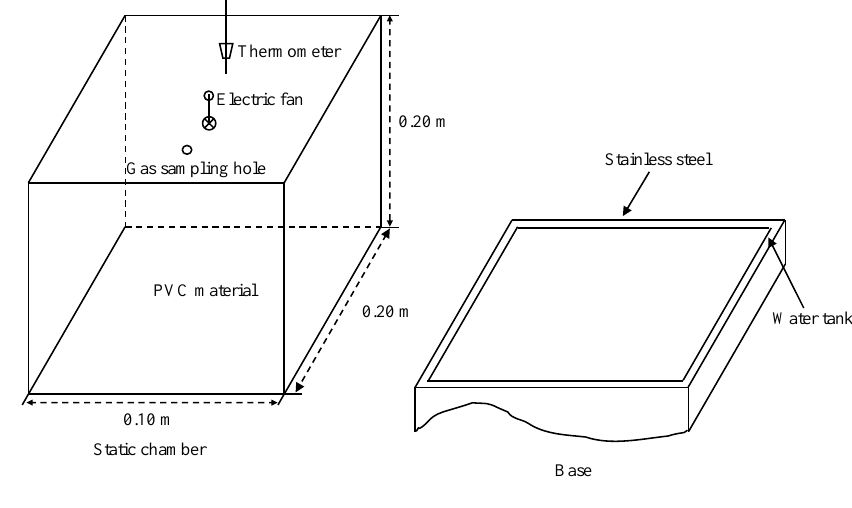
Figure 2. Static chamber.